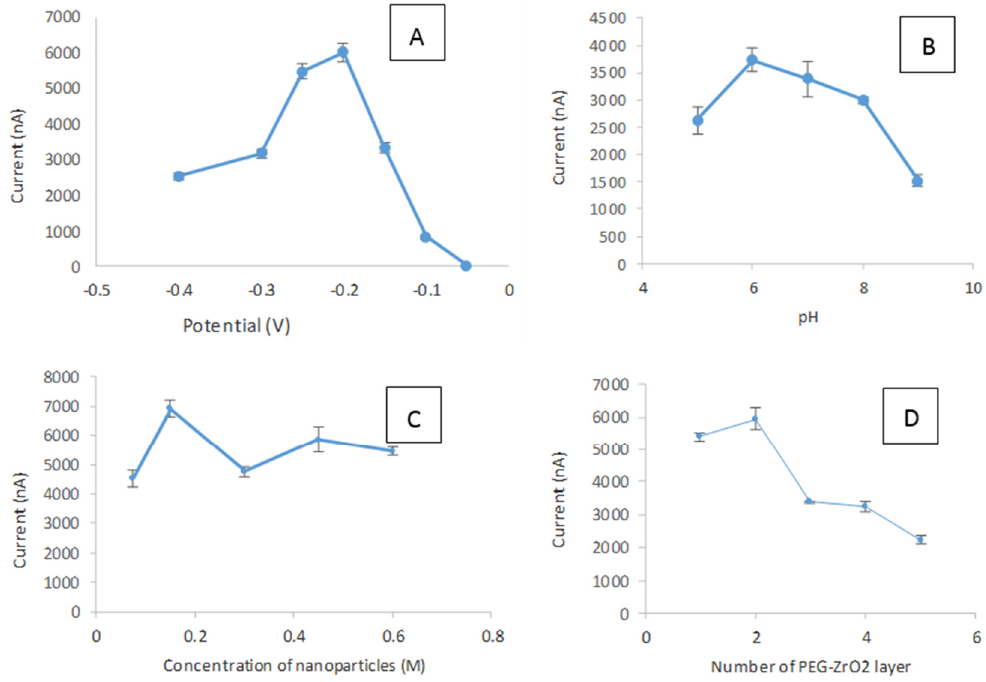
Figure 8. The effect of applied potential ( A ); pH buffer ( B ); concentration of nanoparticles ( C ); and number of PEG-ZrO 2 layers on modified SPCE ( D ). Phenol concentration and applied potential were fixed, respectively, at 10 µM and − 0.2 V vs. AgCl.